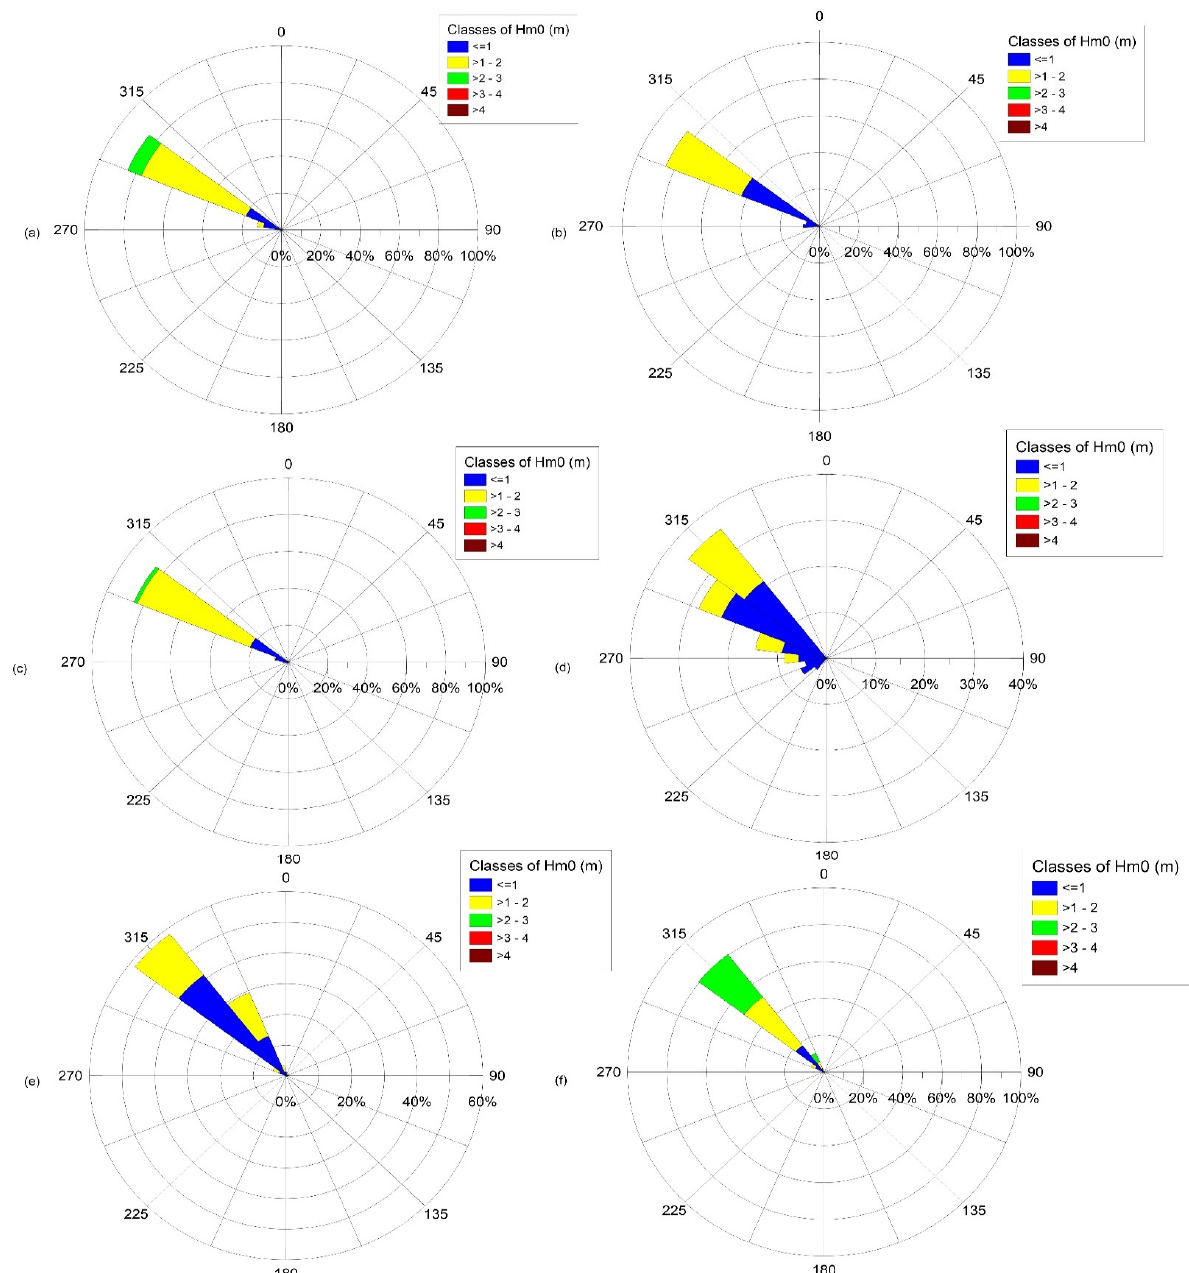
Figure 10. Rose diagram of offshore Hm0 corresponding to time periods of tombolo formation, i.e., in Grapher 9. Grapher